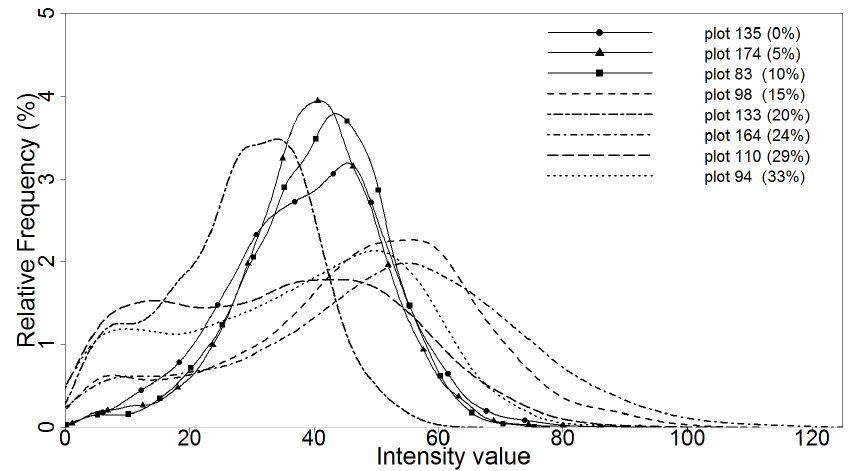
Figure 3. Normalized intensity distributions of lidar first returns (above 2 m) for eight field plots having different mortality ratios. Low mortality plots (mortality ratio <10.5%) are represented in solid lines and high mortality plots in dashed lines.